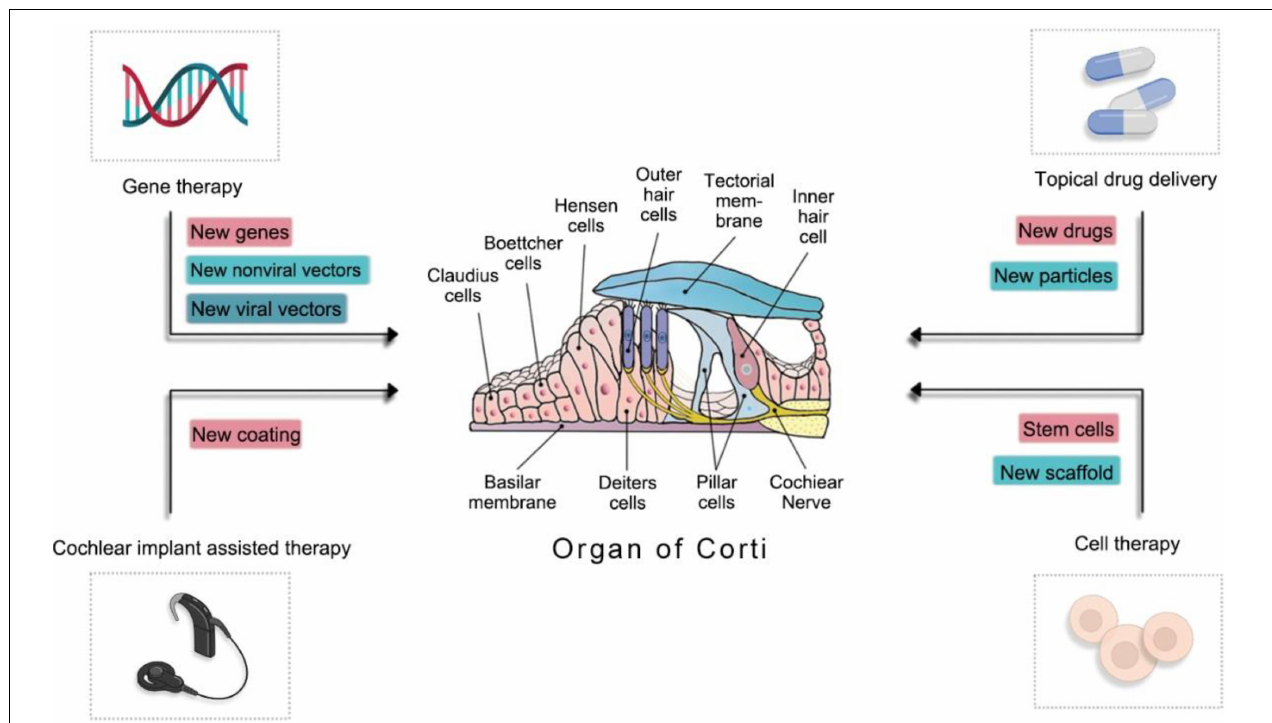
FIGURE 2 | The mechanism of novel materials involved in inner-ear